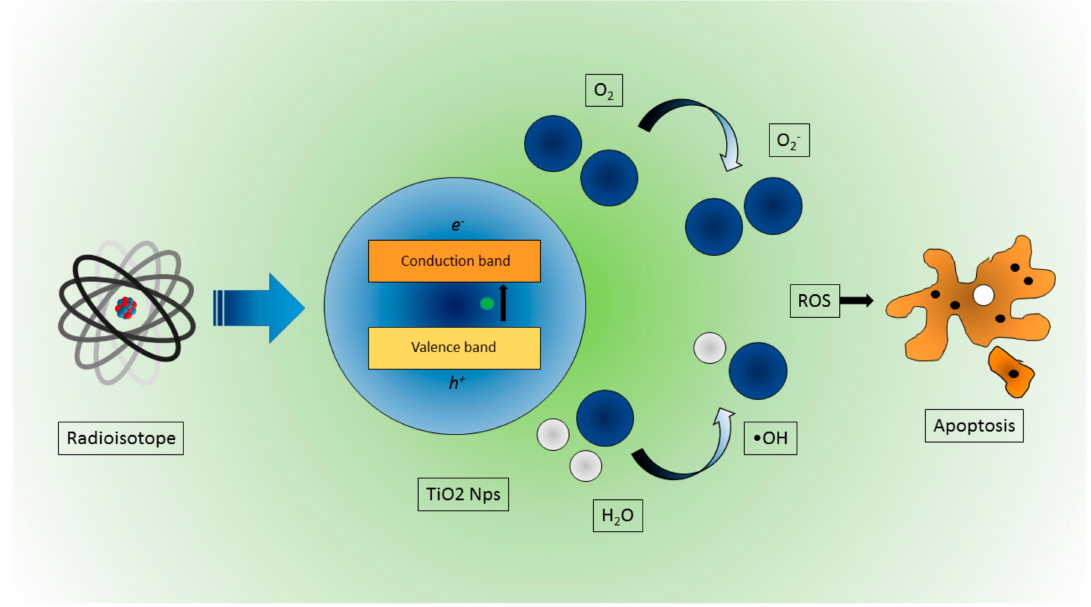
Figure 4. Schematic representation of ROS production due to CR interaction in TiO 2 NPs, leading to cancer cell